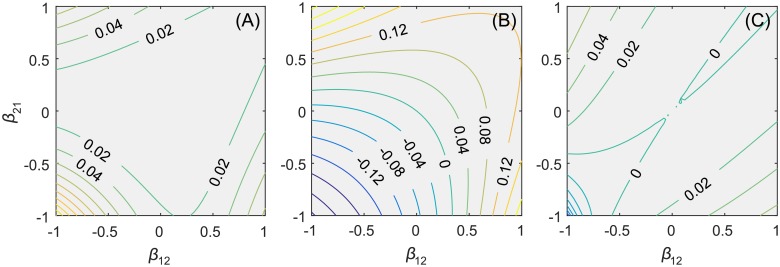
The effects of biological interactions in the two-species bioeconomic model.Contour plot of the responses of normalized (A) joint social value, (B) total resource abundance, and (C) diversity to the interaction type and strength between two species. βij is the interaction direction and strength of species i affecting species j. βij > 0 indicates that species i benefits species j, while βij < 0 indicates that species i is harmful to species j. The positive normalized ratio indicates that cooperative management is superior to non-cooperative management in this indicator and related interacting styles and vice versa.